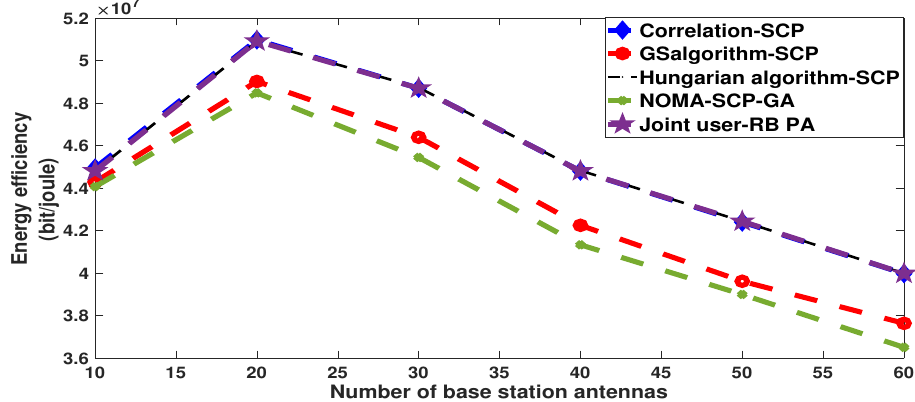
Figure 4. EE versus number of BS antennas, with U = 10 users, ZF